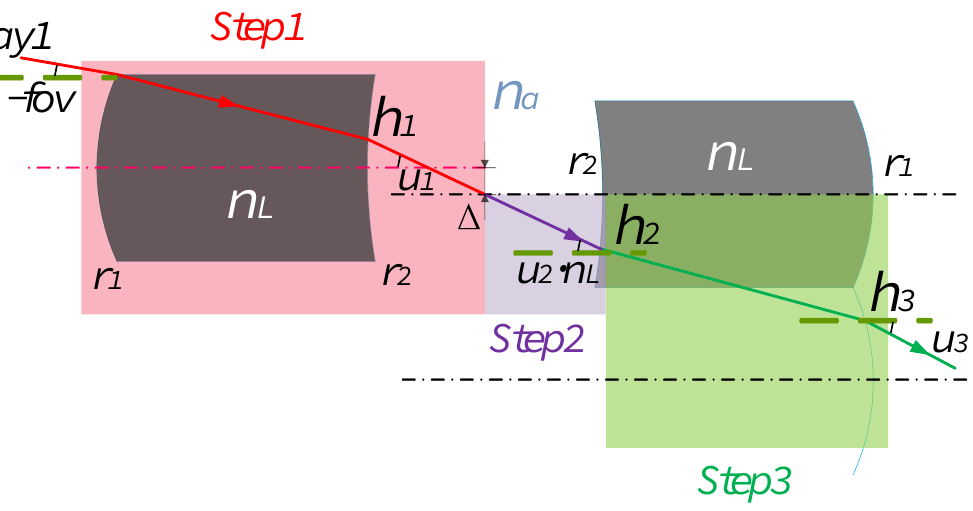
Figure 7. Schematic of the ray-tracing steps of the array system.